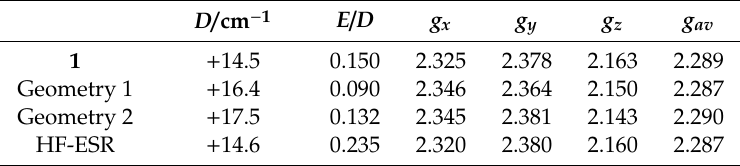
Table 1. Zero-field-splitting (ZFS) parameters obtained by complete active space self-consistent field (CASSCF) / N-electron valence second-order perturbation theory (NEVPT2) calculations compared to HF-ESR. D / cm − 1 E / D g x g